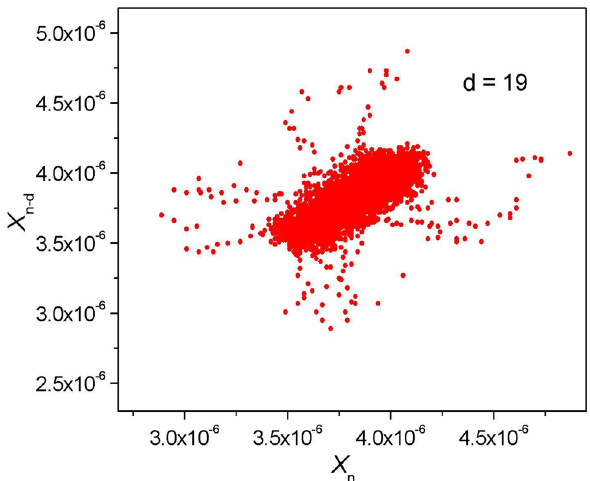
Figure 4. Butterfly attractor (calculated Poincaré section) for the germinating pollen grains of hyacinth on the transition from germination to the optimal growth temperature showing the cyclicality ( d = 19 ) in this chaotic system, which indicate that a short-term ~ 19/(4.1 Hz) = 4.64 ± 0.5 s oscillation is the fundamental frequency ( f 0 ≈ 0.23 Hz) in the